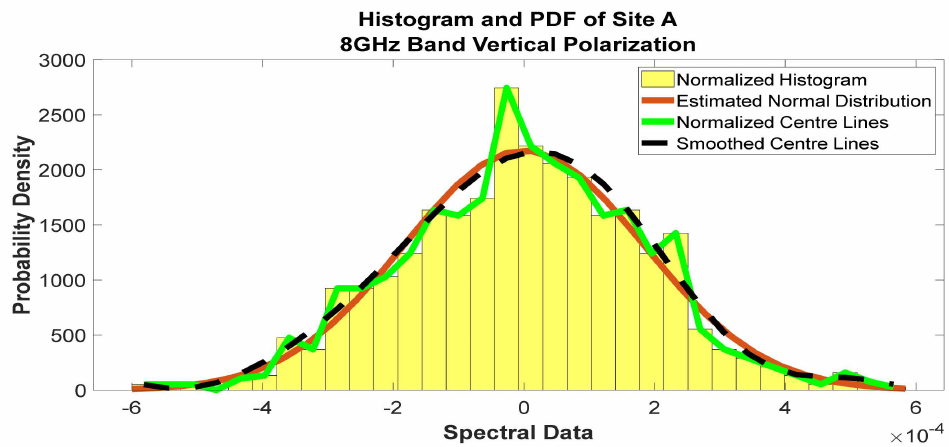
Figure 31. Histogram and PDF of the frequency scan for site A at 8 GHz vertical polarization.